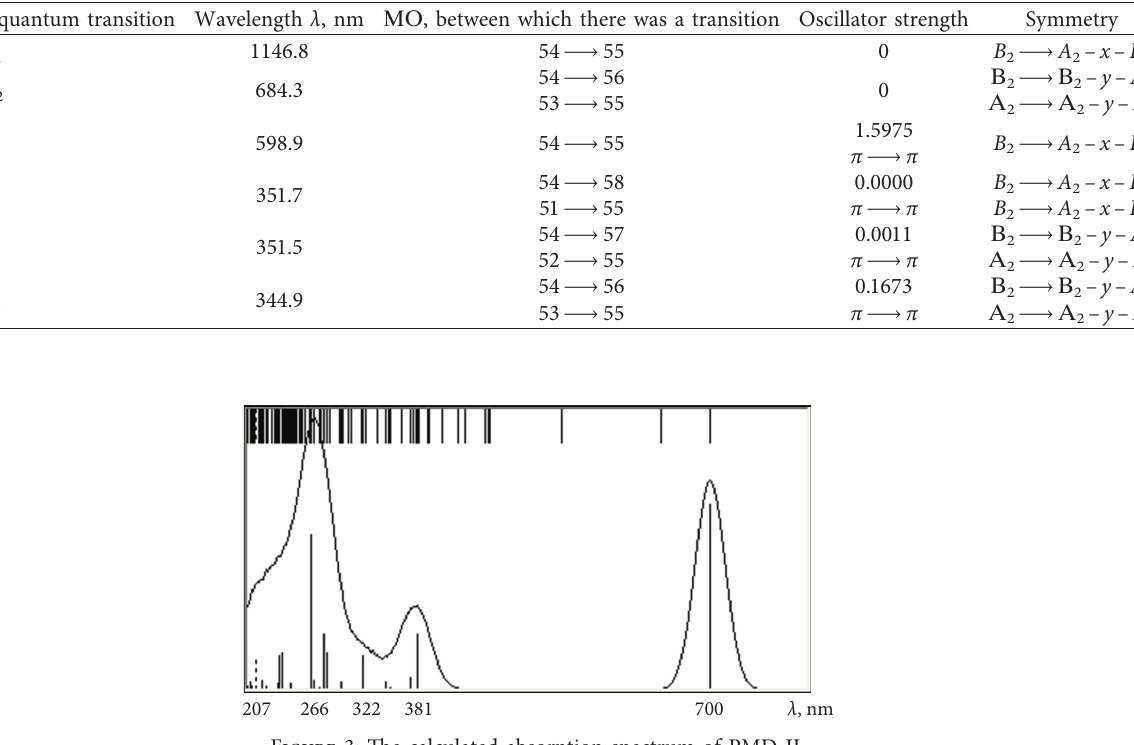
Table 3: Calculated absorption spectrum of PMD-I.